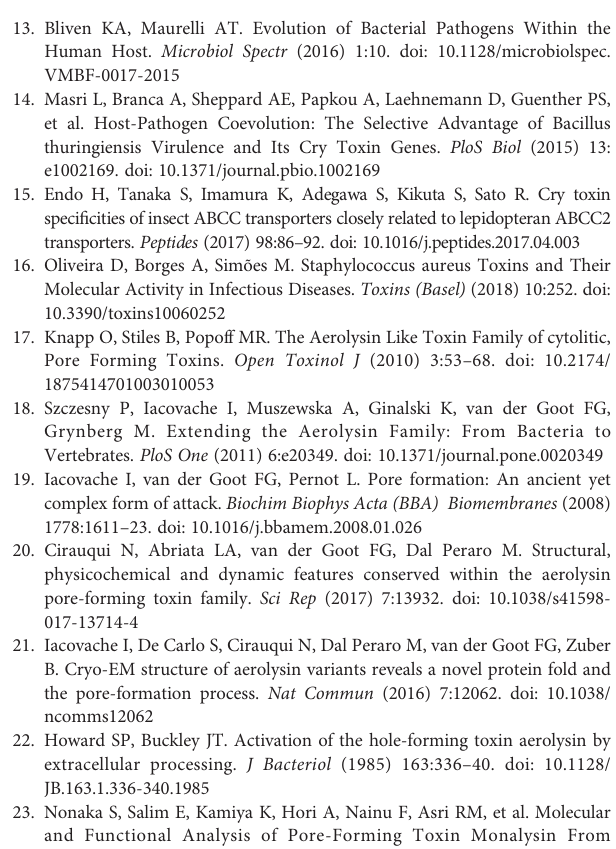
Supplementary Figure 1 | Dot plot of the different biomphalysins and their surrounding genomic regions. The fi rst row and column represent all the biomphalysinsordered from1to23,followedbythe(upto20kbp) genomicregions surrounding and including the biomphalysin. Blue circle, conserved structure between biomphalysins 5 and 6. Green circle, similarity region near biomphalysins 11 and 22. Supplementary Figure 2 | Sequence alignment and predicted topology of biomphalysin proteins. Multiple alignment of the biomphalysin proteins was performed using CLUSTALO. Conserved amino acid residues identi fi ed in 75% of all sequences are highlighted with a black box. Amino acids containing similar chemical properties are shown in a gray box. Key amino acids whose roles are described as important for oligomerization and lytic activity are indicated in white on a red background. The positions of secondary structure elements were predicted using the server PROMALS3D. a -helices and b -strands are indicated by “ h ” and “ e ” , respectively. The putative peptide signal indicated in brown were predicted on SignalP 4.1 server (153). The Transmembrane Domain boxed with a blue dashed line was predicted using the PRED – TMBB server. The signal peptide is in brown,